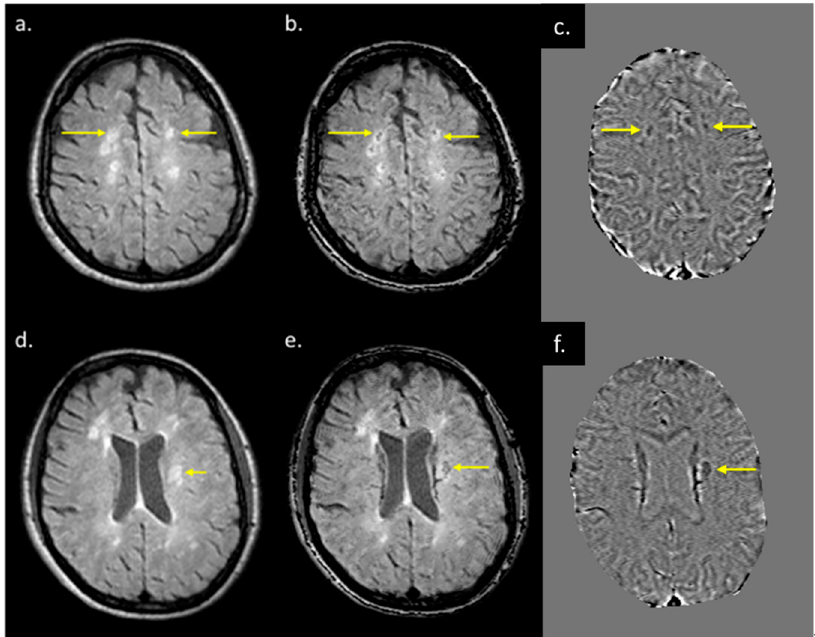
Figure 6. T2 FLAIR images ( a , d ), fusion image of susceptibility weighted imaging (SWI) phase and T2 FLAIR ( b , e ), and SWI phase ( c , f ) from two patients both with QSM and T2 FLAIR visible lesions. When T2 FLAIR images ( a , d ) have an SWI phase mask superimposed on them ( c , f ), possible regions of demyelination (shown by yellow arrows in ( b , e ) can be differentiated from those showing inflammation alone ( b , e ).